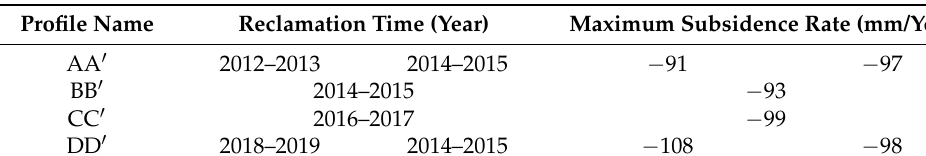
Table 3. Subsidence rate of profile in different periods.